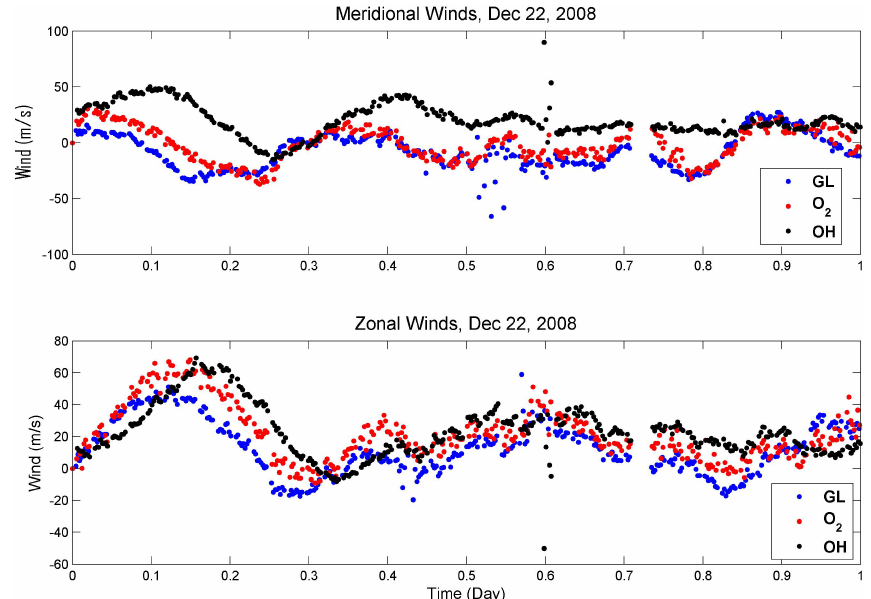
Fig. 11. Time series of the zonal and meridional winds for all three emissions on 22 December 2008. It is interesting to note that larger scale variations first show up in the green-line winds, followed by O 2 and then OH. This is expected for upward propagating tides for which the phase front propagates downward. Standard errors for each wind measurement are smaller than the dots in the figure for green line and OH and about the size of the dot for O 2